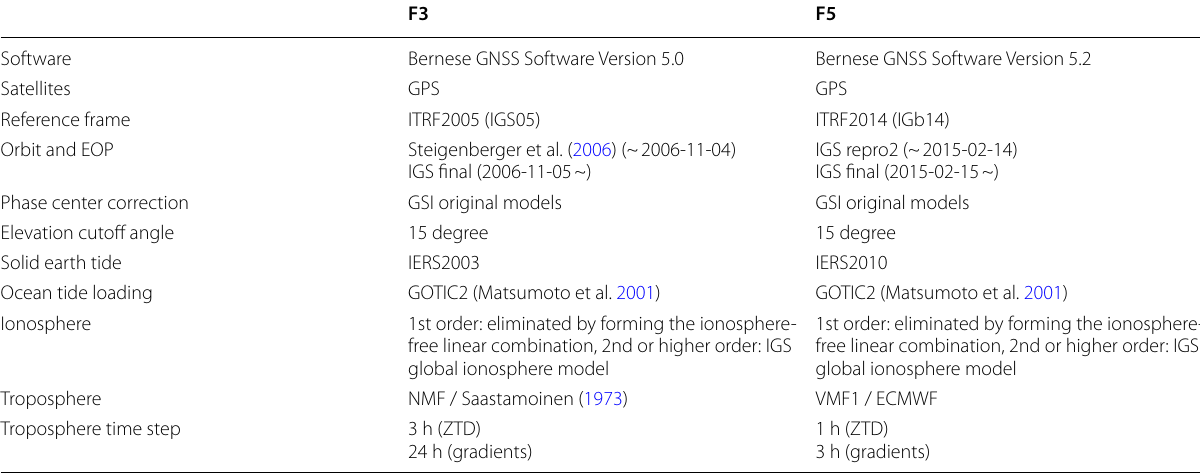
Table 4 Models and conventions used for